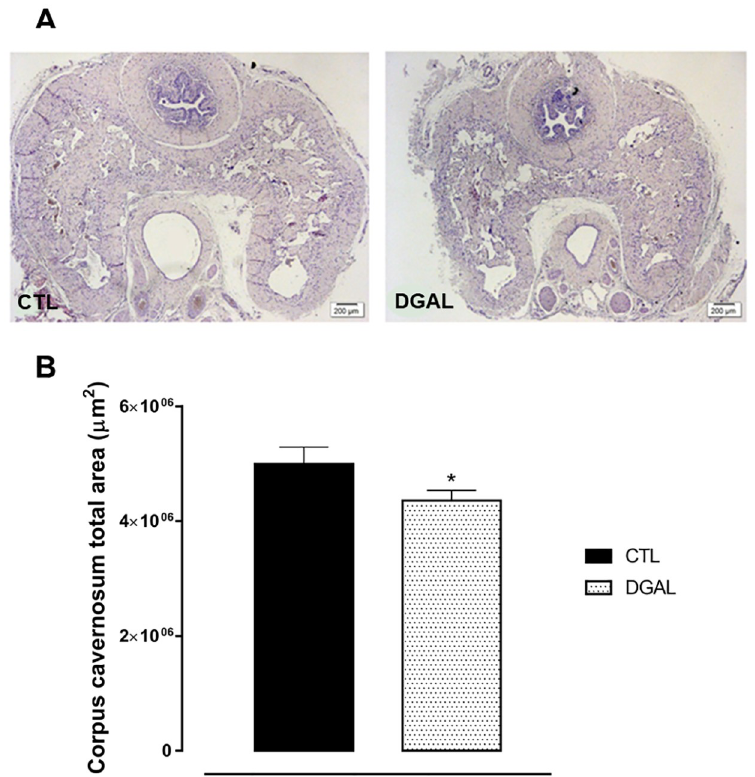
Fig 5. Photomicrographs (A) and histomorphometric analysis (B) of the total corpus cavernosum area (8 μ M) isolated from rats, at eight weeks of treatment. Groups: CTL (vehicle); DGAL (D-(+)-galactose 150 mg/Kg). Scale bars, 200 μ m. The data are expressed as mean values of total corpus cavernosum area ± SEM (n = 3). The data were analyzed using the Student’s t-test. � p < 0.05 vs CTL.